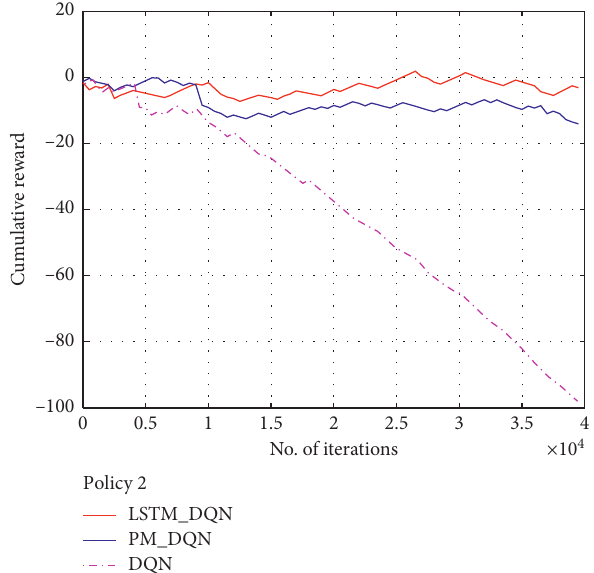
Figure 9: Relationship between the number of iterations and success rate (policy 2).